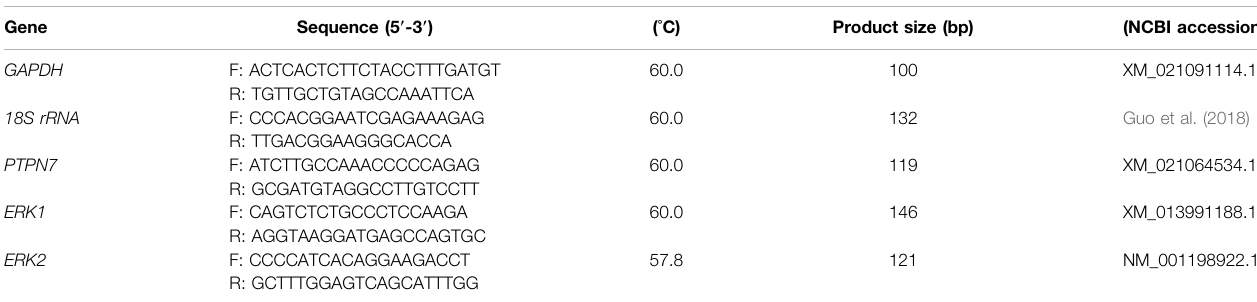
TABLE 1 | Primers used for quantitative reverse transcription PCR